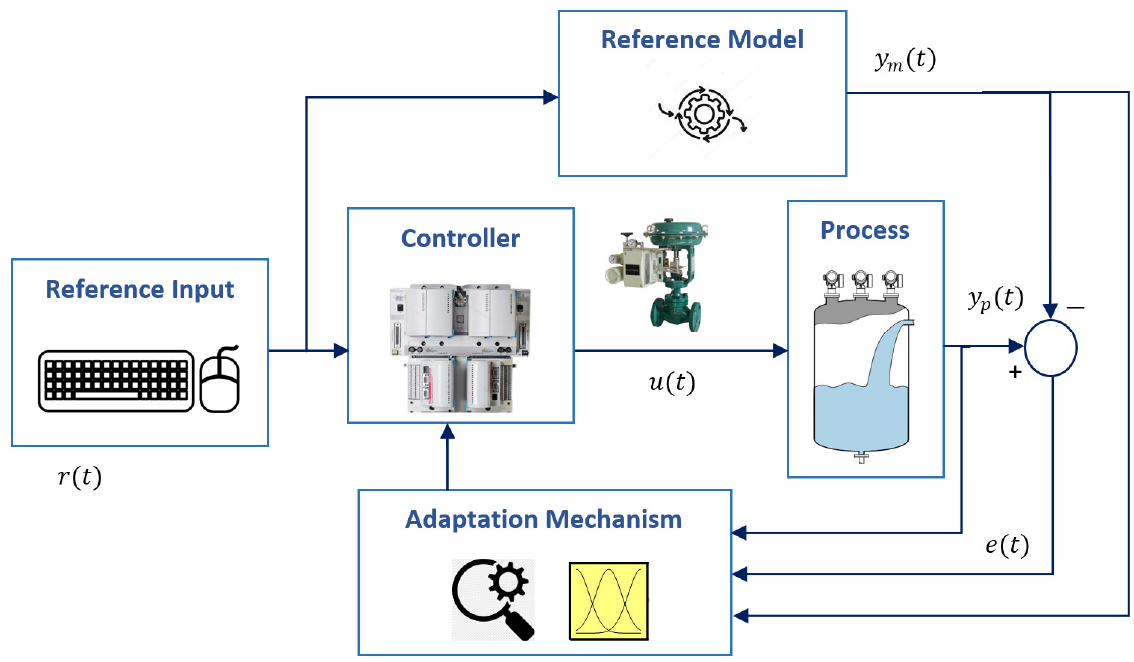
Figure 4. MRAC block structure applied to gas cleaning tank level control process.